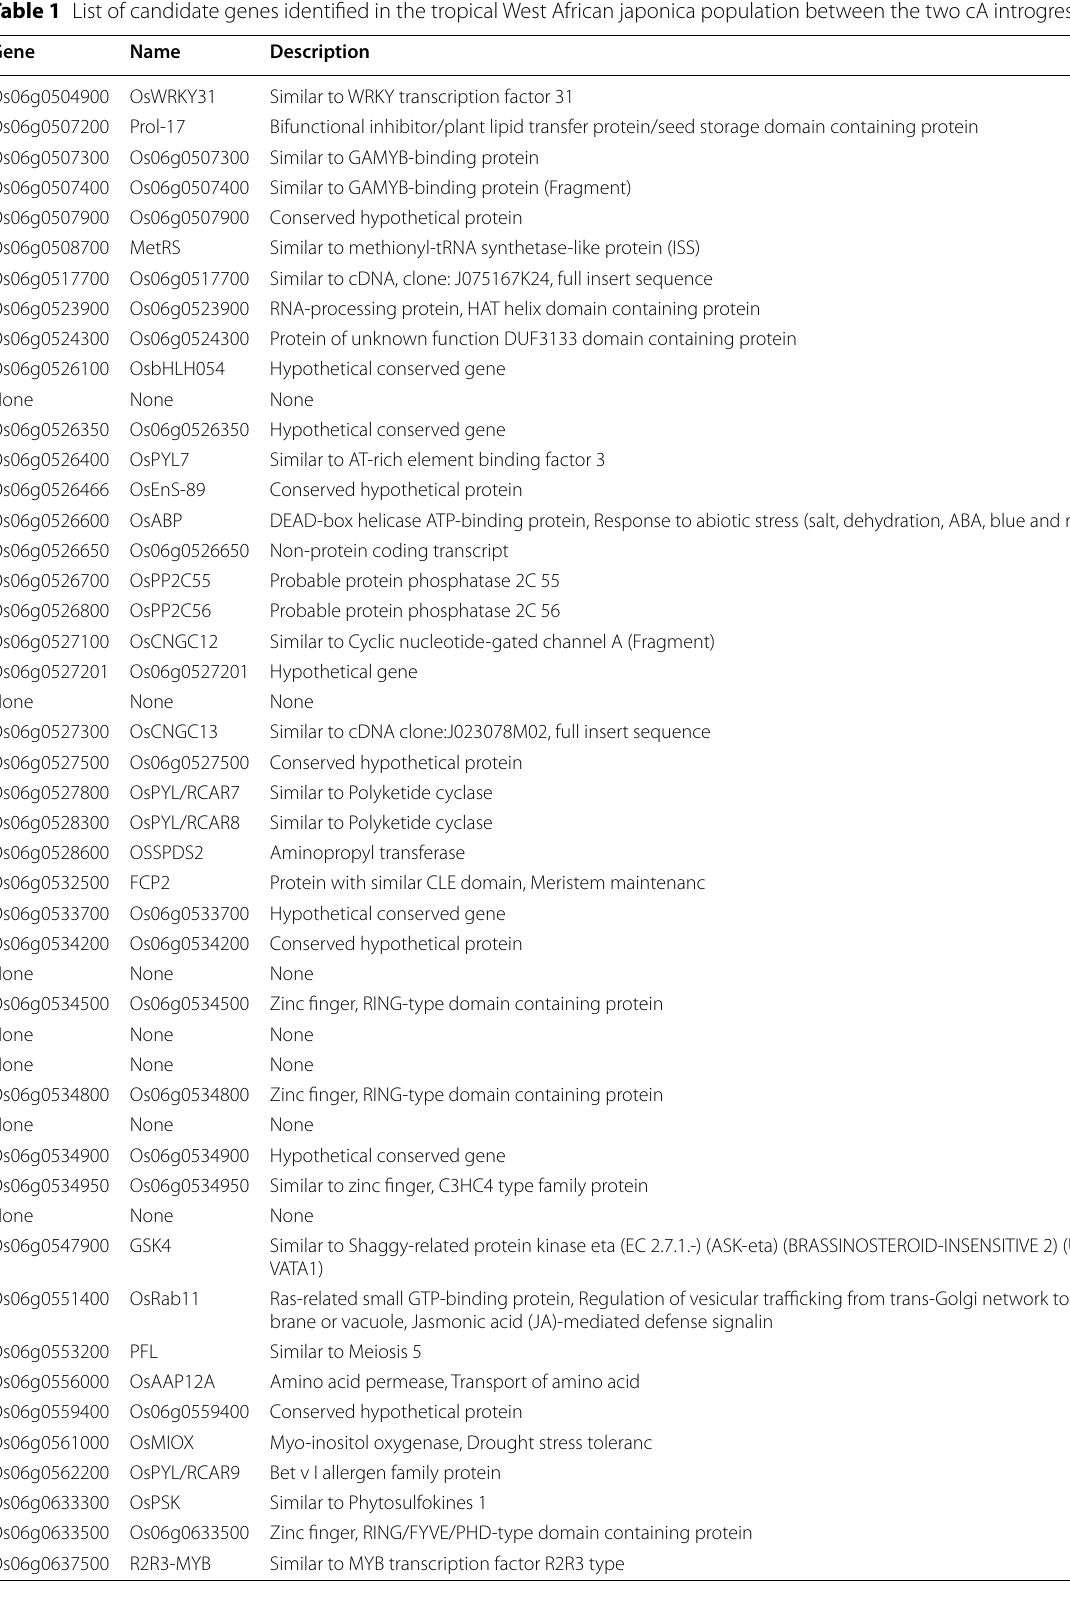
Table 1 List of candidate genes identified in the tropical West African japonica population between the two cA introgression regions